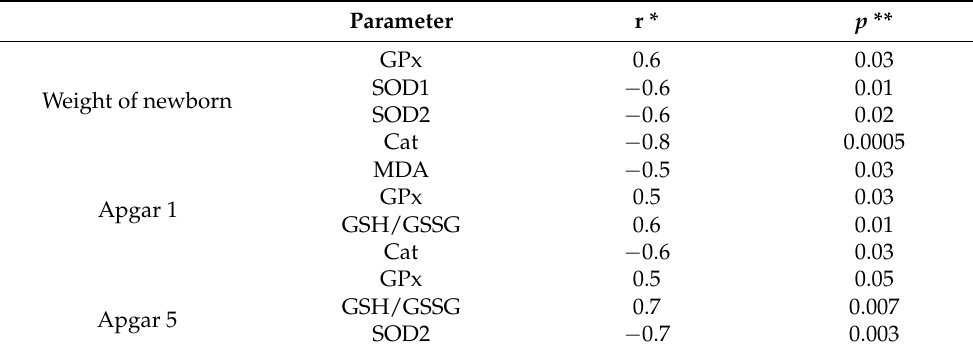
Table 2. Correlation of clinical assessments with markers of pro- and anti-oxidant systems in FGR newborns. Parameter r *